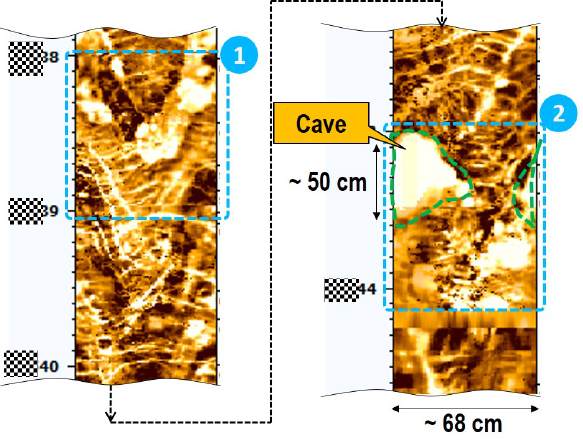
Figure 4. Example of vugs preceding a